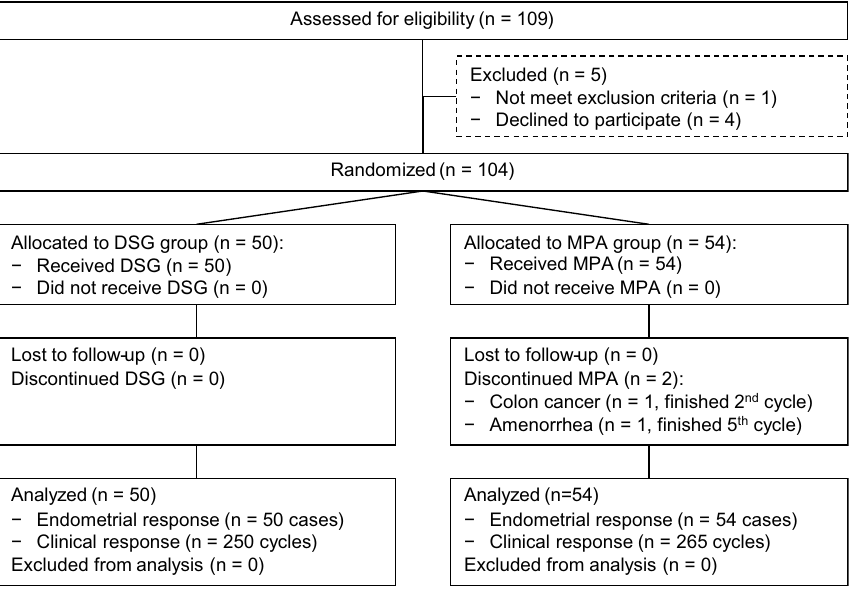
Figure 1. CONSORT participant flow. DSG desogestrel, MPA medroxyprogesterone